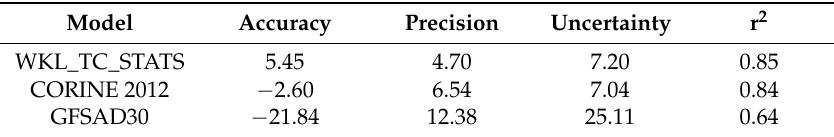
Figure 4. Comparison of province level fraction of cropland derived from maps and statistics from Turkish Statistical Institute at NUTS3-level (provinces; n = 81). Cropland extent mapped from WKL_TC_STATS (left), CORINE 2012 (center), and GFSAD30 (right). Grey line shows 1:1 line, the red dashed line represents linear regression line of the mapped area against statistics. Table 5. Model performance and summary statistics of linear regressions with NUTS3-level (n = 81), using cropland extent statistics as a dependent, and mapped cropland extent from WKL_TC_STATS, CORINE 2012, and GFSAD30 products as the independent variable. Accuracy, precision, and uncertainty in thousand